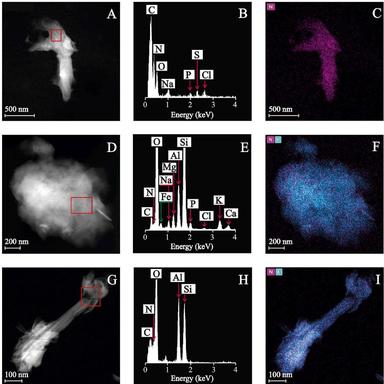
UHR-TEM microphotographs, EDX spectra and elemental maps of: hLF (a-c); hLF-Mt (d-f); hLF-Hal (g-i). EDX spectra were performed in red squares. (For interpretation of the references to colour in this figure legend, the reader is referred to the web version of this article.)